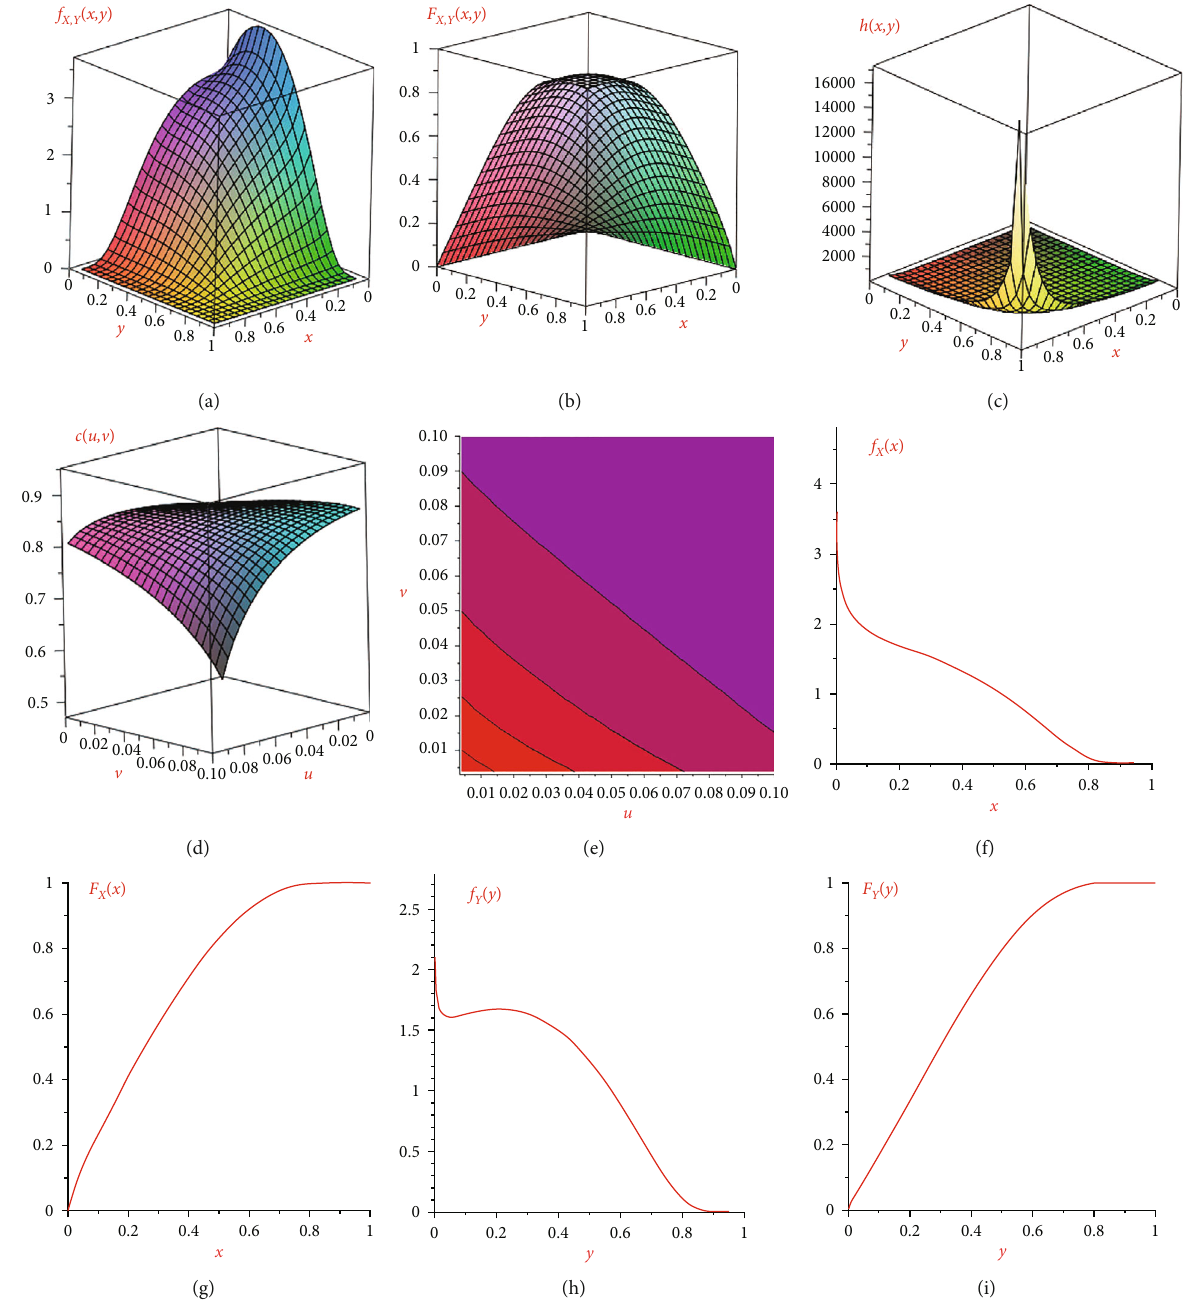
Figure 15: Statistical quantities for ð X , Y Þ ~ BIUPW ð 2 : 0,1 : 0,0 : 8,0 : 2, − 0 : 1, − 0 : 5 Þ